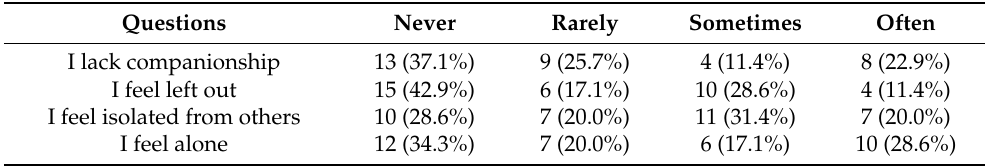
Table 4. Answers of 40 parents of children with disabilities related to their level of solitude during the pandemic in Quebec (Canada) 1